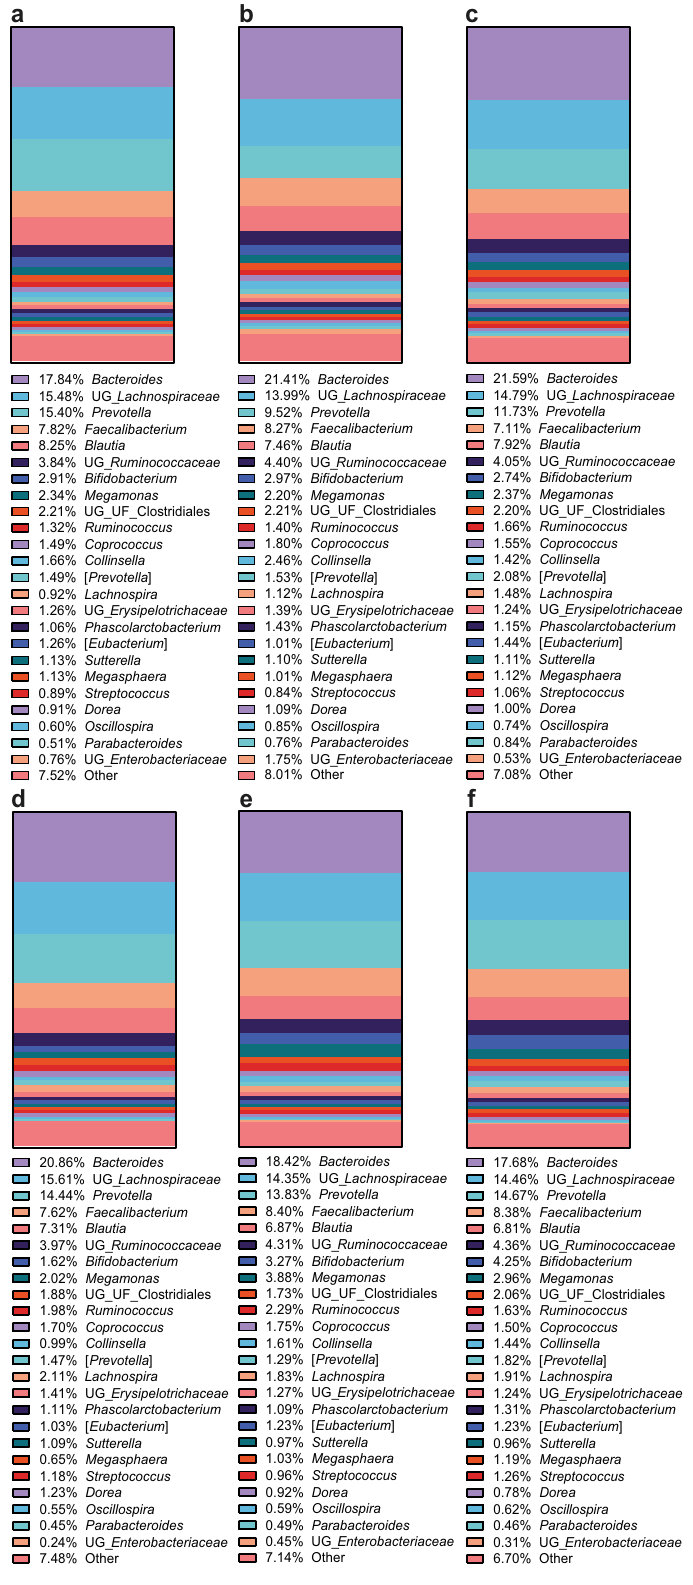
Figure 1. Comparison of the relative abundance of bacterial genera for the three different doses of spices intervention at Day 0 (baseline) (a-c) and Day 2 (d-f) for D0C, D1C and D2C respectively. ‘Other’ was categorised as less than 1% of bacterial OTUs among the population. Bacteria at baseline or at Day 2 were not significant different between intervention sessions. D0C = Meal with no spices intervention, D1C = Meal with low (6 g) mixed spices intervention, D2C = Meal with high (12 g) mixed spices intervention, UG unknown genus, UF unknown family. n = 15 each